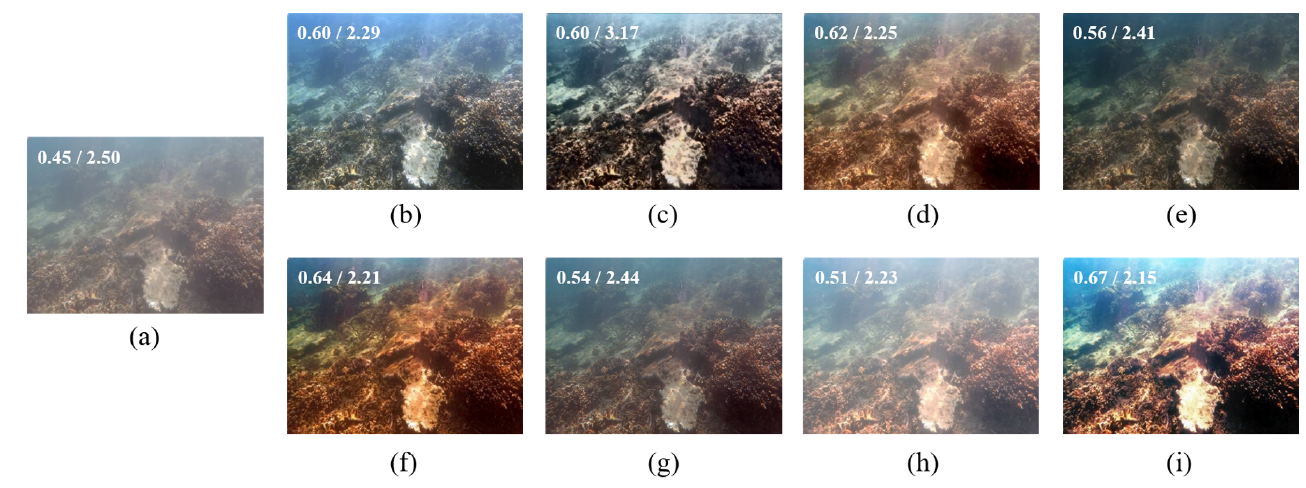
Figure 5. ( a ) Hazy and bluish underwater image, and its restored/enhanced results obtained using ( b ) Fusion-based[43], ( c ) Retinex-based[44], ( d ) IBLA[10], ( e ) AGC[45], ( f ) GDCP[9], ( g ) UWCNN[26], ( h ) BL-TM[40], and ( i ) the proposed method. The number on the top-left corner of each image refers to its UCIQE/NIQE score.